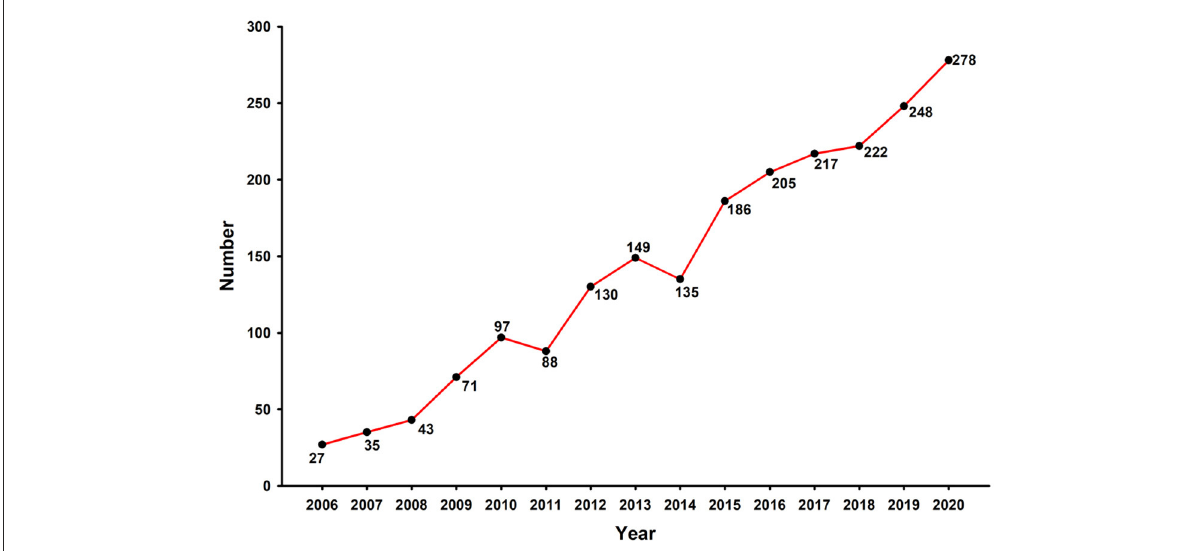
FIGURE1 The number of ESD publications indexed by WoSCC, 2006-2020.